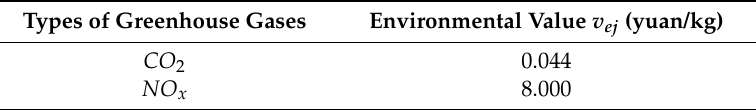
Table 2. Environmental values of different greenhouse